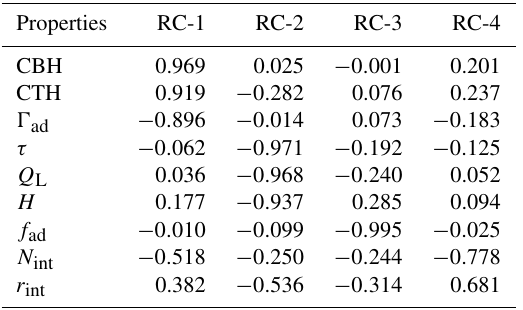
Table 4. Pearson correlations between the logarithm of the cloud properties and the RCs. Degree of correlation (absolute values): (a) very weak: below 0.2, (b) weak: [ 0 . 2 , 0 . 4 ) , (c) moderate: [